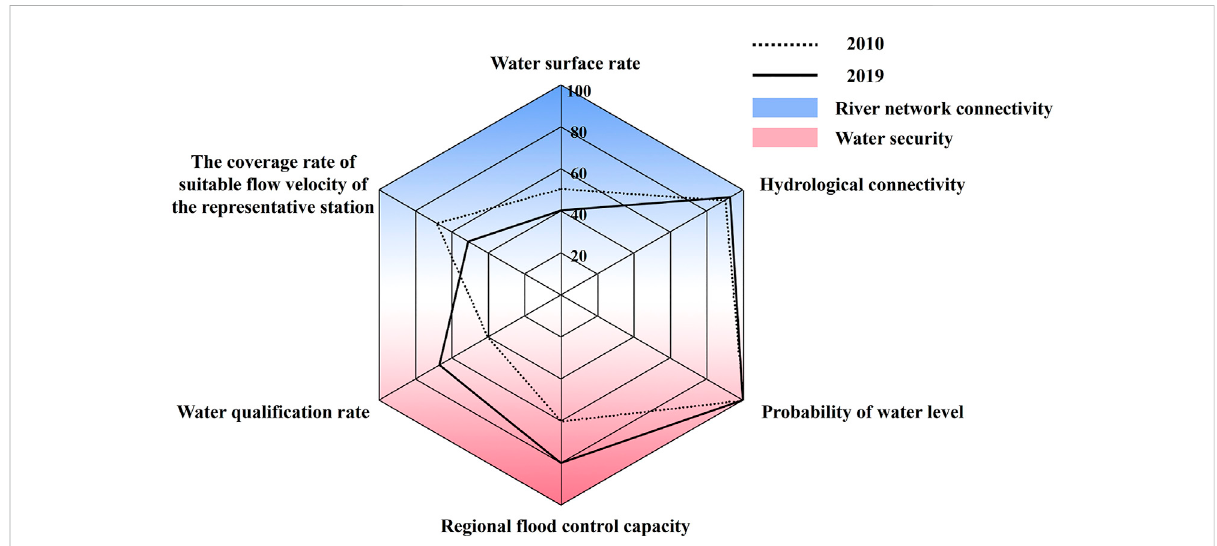
FIGURE 6 Radar graph of the scores of the indicators of river network connectivity and water security for 2010 and 2019.